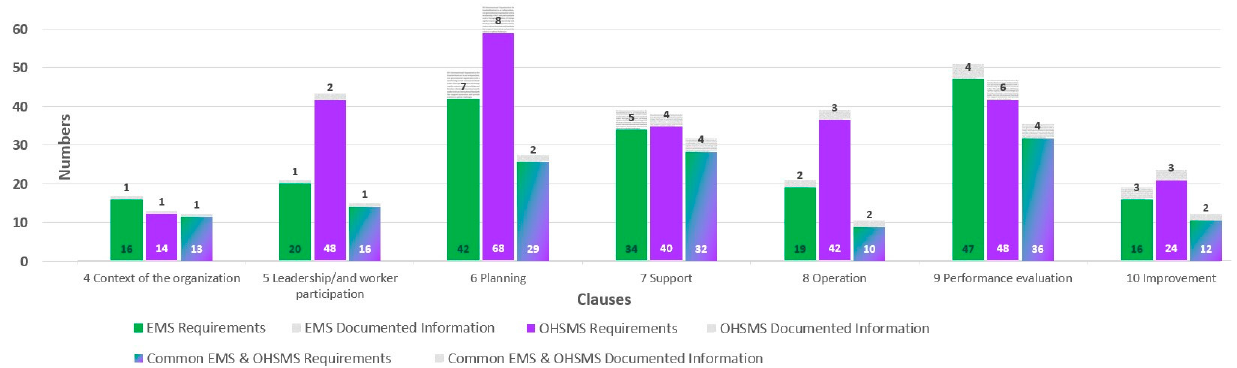
Figure 6. Number of requirements and documented information for EMS and OHSMS (source: authors).